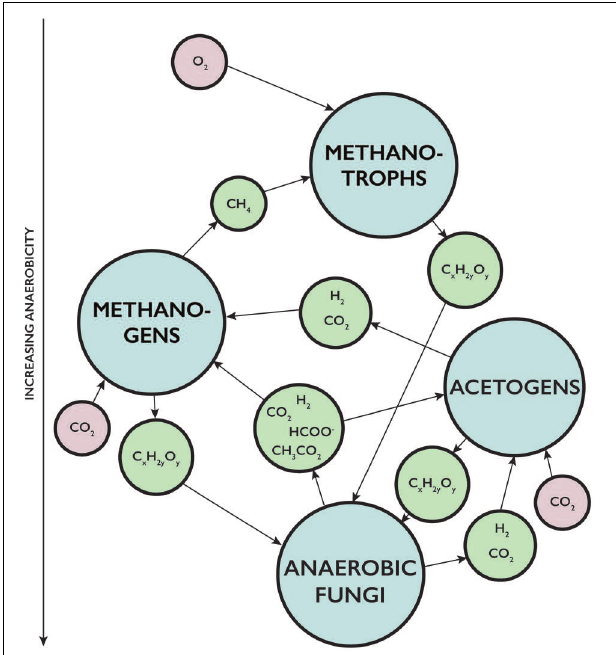
FIGURE 2 | Scheme for proposed interactions between anaerobic fungi and hydrogen-driven prokaryotic communities such as methanogens and acetogens in an anoxic environment. Also their impact on associated aerobic microbial communities like methanotrophs. Arrows show metabolic products and reaction pathways. (C x H 2y O y ) is carbohydrates, (HCOO) is acetate, and (CH 3 CO 2 ) is